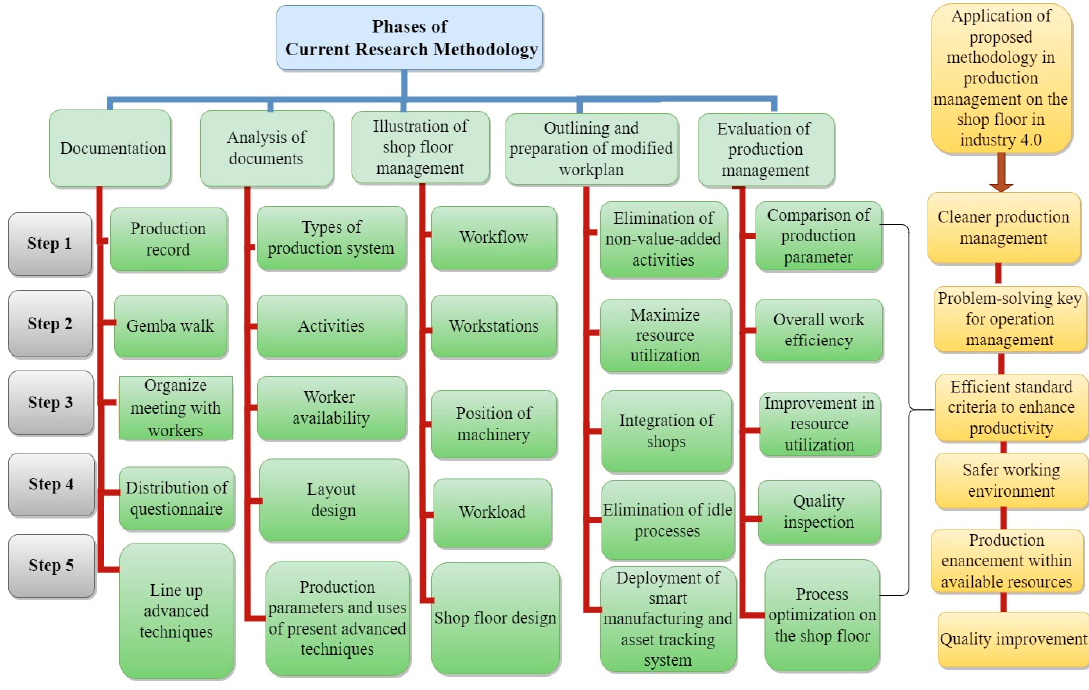
Figure 3. Phases of the proposed methodology.